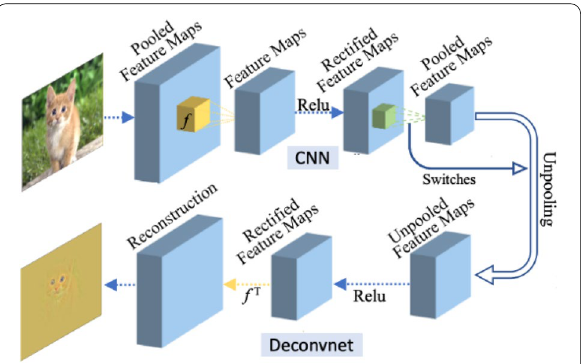
Figure 12 Structure of deconvnet, adapted from Ref. [93]